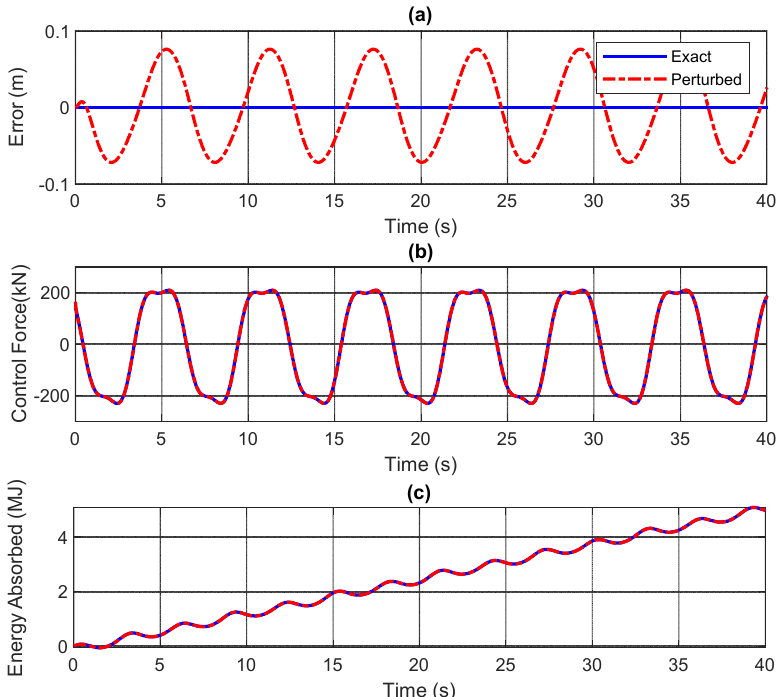
Figure 9. ( a ) Displacement error between reference and WEC displacement, ( b ) Control Force, and ( c ) Energy Absorption of the Exact Model and the Perturbed Model.